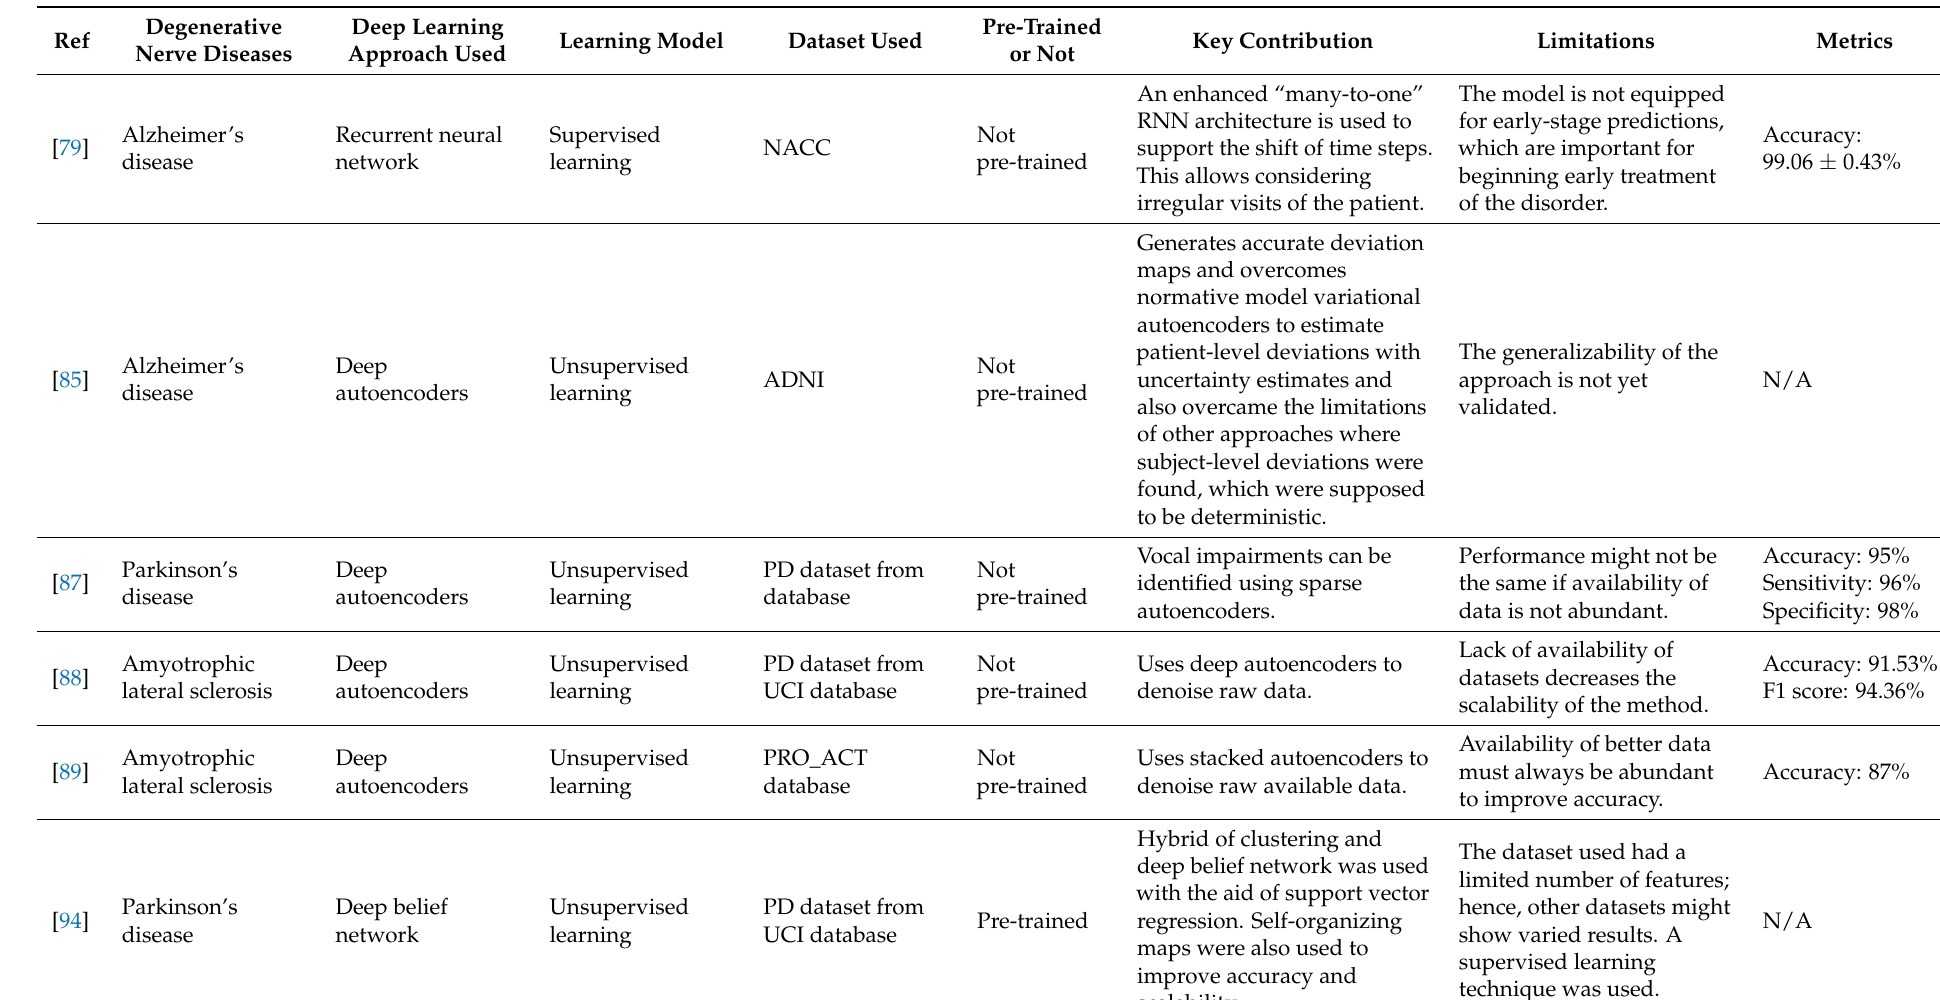
Table 2. A summary of works on deep learning for degenerative nerve disease